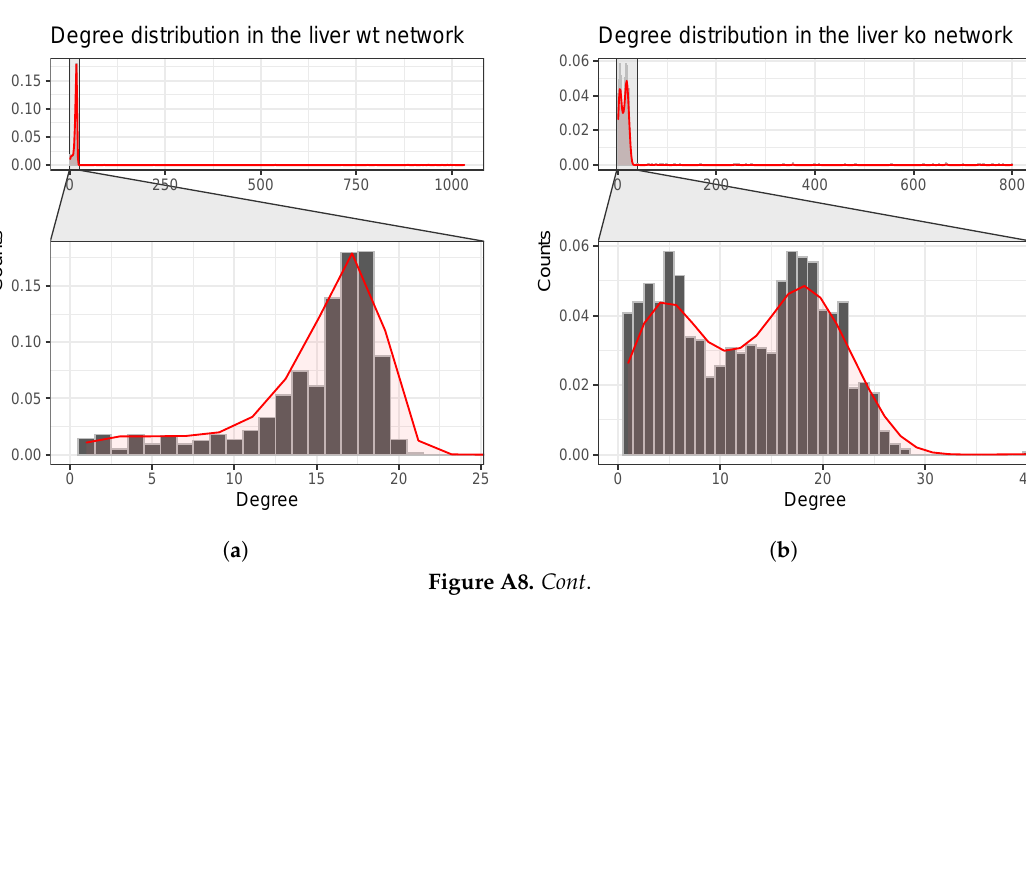
Figure A7. Enrichment analyses based on node exclusiveness of ( a ) liver and ( b ) spleen networks. wt refers to nodes exclusively present at those networks reconstructed from wt samples; ko refers to nodes exclusively present at networks reconstructed from Ly6E ∆ HSC samples; both addresses shared nodes between wt and ko networks. Gene ratio is defined by the number of genes used as input for the ernichment analyses associated with a particular GO term divided by the total number of input genes.